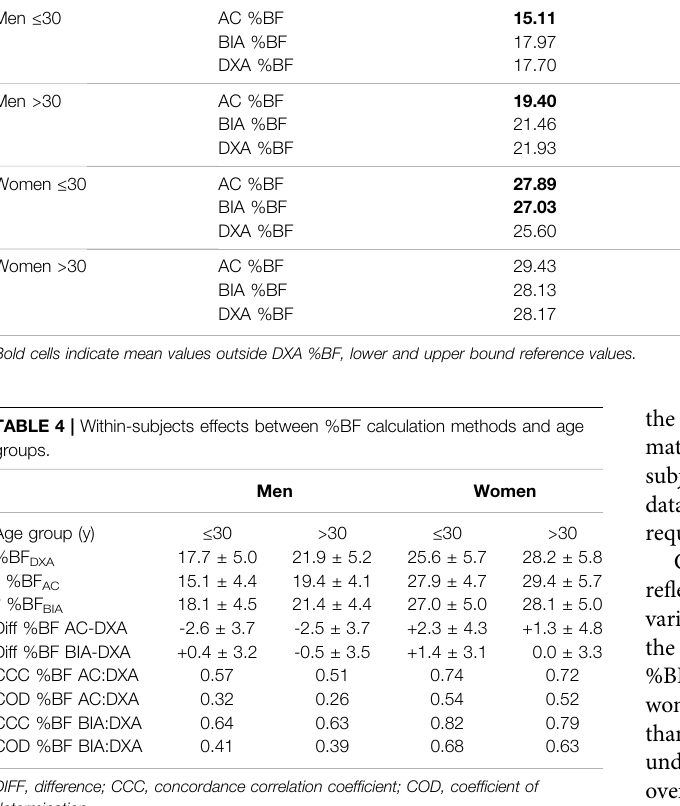
TABLE 3 | Within-subjects effects between %BF calculation methods and age groups.